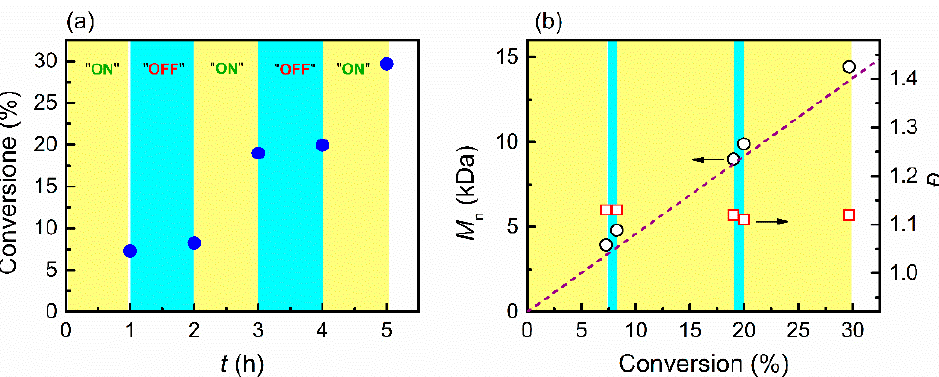
Figure 6. ( a ) Kinetic plots and ( b ) evolution of M n and Ð with conversion for potentiostatic e ATRP of 75% (v/v) styrene in DMF at E app = E 1/2 . Conditions: [St]:[EBiB]:[Catalyst] = 654:1.5:0.1; [Cu II ] = 10 − 3 M. The dashed line represents the theoretical molecular